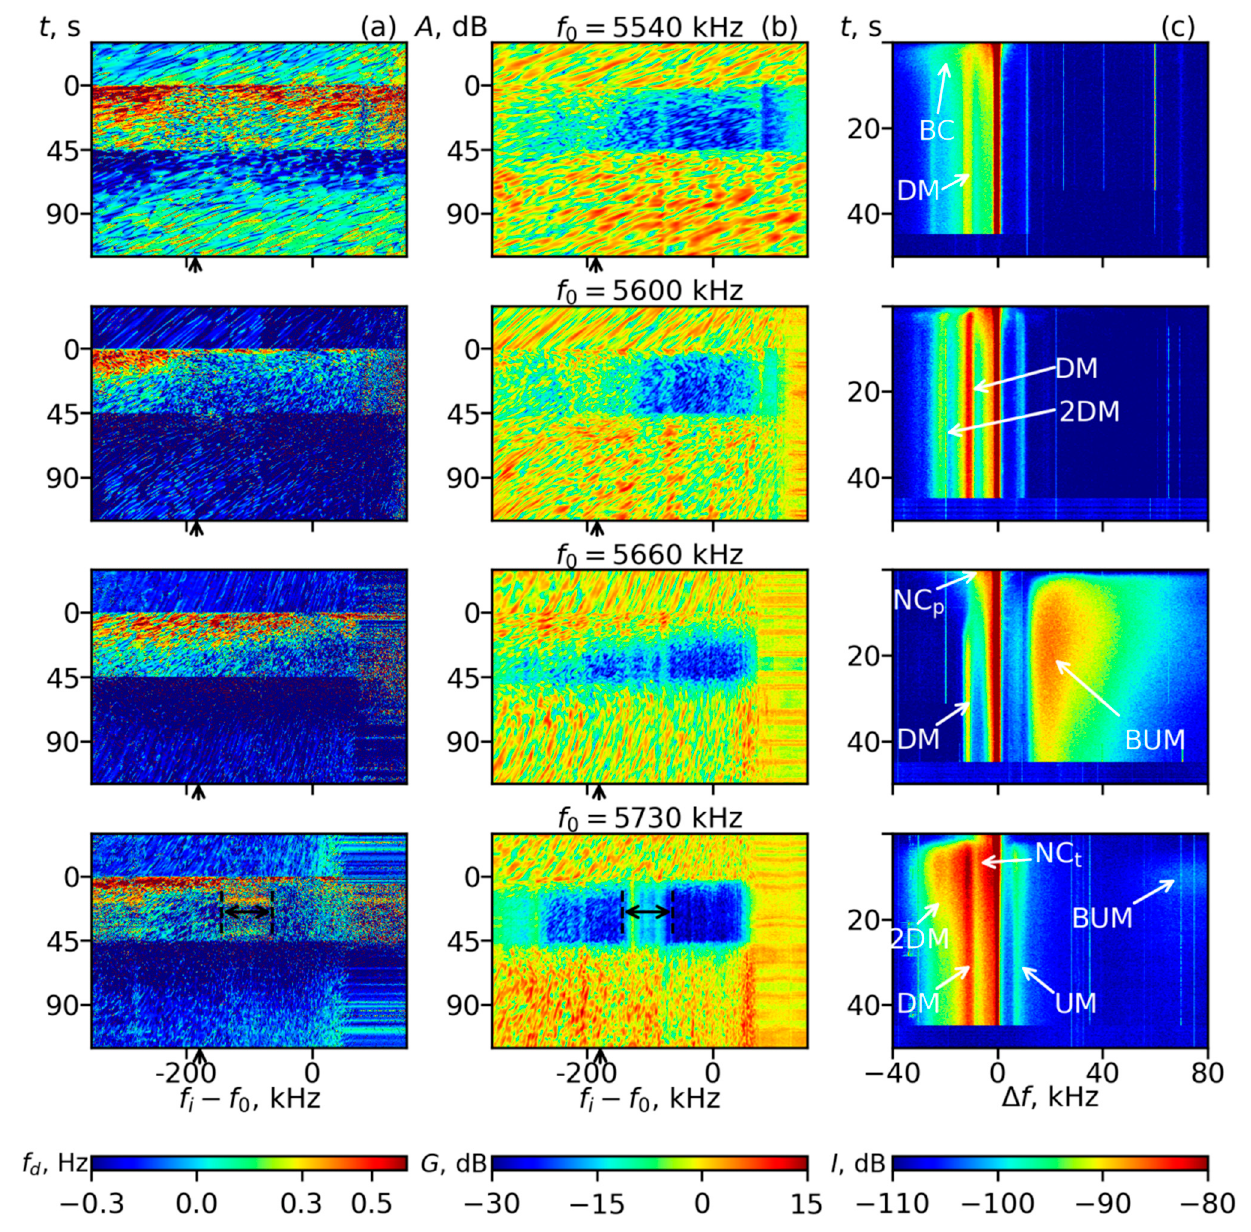
Figure 1. Data obtained in the cycles for the PW reflection heights z r 0 (cid:38) 230 km. The PW frequencies f 0 are shown above the ( b ) panels. Column ( a ): The Doppler frequency shifts (colors) vs. time t and diagnostic wave spectral component frequency shift f i – f 0 . Column ( b ): Normalized amplitude of the diagnostic waves G (color) vs. t and frequency shift f i – f 0 . Column ( c ): The SEE spectrograms. Prominent stimulated electromagnetic emission spectral features, the ponderomotive narrow continuum (NC p ), thermal narrow continuum (NC t ), downshifted maximum (DM), 2nd downshifted maximum (2DM), upshifted maximum (UM), broad continuum (BC) and broad upshifted maximum (BUM) are marked. The arrows below the frequency axes correspond to the plasma frequency at the upper hybrid (UH) resonance height z UH0 , f i − f p ( z UH0 ) = ((cid:1858) (cid:2868)(cid:2870) − (cid:1858) (cid:2913)(cid:2870) ) (cid:2869)/(cid:2870) in all figures. Double arrows show the contaminated frequency range for the phase data processing.